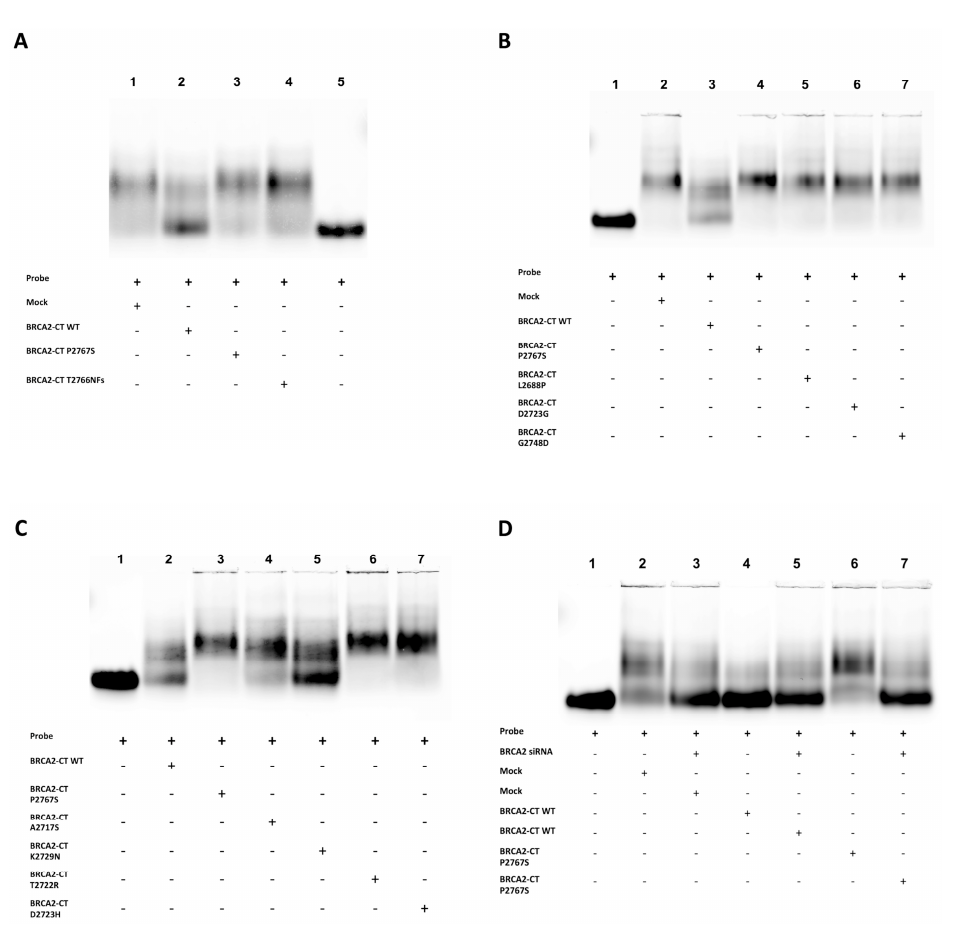
Figure 4. The p.Pro2767Ser likely pathogenic variant hampers the binding of BRCA2 to DNA. ( A ) The ssDNA binding assay of nuclear extracts from 10 G γ -IR mock-transfected cells and cells expressing the BRCA2-CT wt, and the BRCA2-CT P2767S and BRCA2-CT T2766NFs proteins. In the mock sample, the endogenous BRCA2-RAD51 complex was bound to ssDNA. The electrophoretic migration was delayed in the BRCA2-CT P2767S, and the BRCA2-CT T2766NFs samples, but not in the BRCA2-CT wt sample. ( B ) The ssDNA-binding assay of BRCA2-CT WT and BRCA2-CT P2767S compared to the pathogenic BRCA2-CT controls. BRCA2-CT P2767S showed a similar migration delay compared to all the pathogenic BRCA2-CT controls. ( C ) The 2 benign controls shifted similarly to BRCA2-CT WT, while the remaining pathogenic controls behaved similar to BRCA2-CT P2767S, in which endogenous BRCA2 can act properly and binds ssDNA after irradiation. Due to the dimension of the electrophoretic chamber, up to seven samples per run were loaded. ( D ) The effect of the endogenous BRCA2 silencing assessed by the in vitro ssDNA-binding assay on silenced and non-silenced samples 48 h after transfections. In the BRCA2-silenced-cells, there were no differences of migration pattern among the samples.